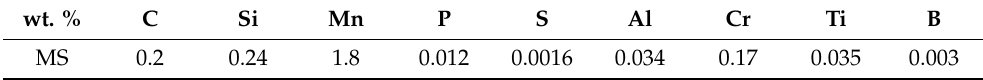
Table 1. Chemical composition of the martensitic steel (MS) measured by OES. wt. %